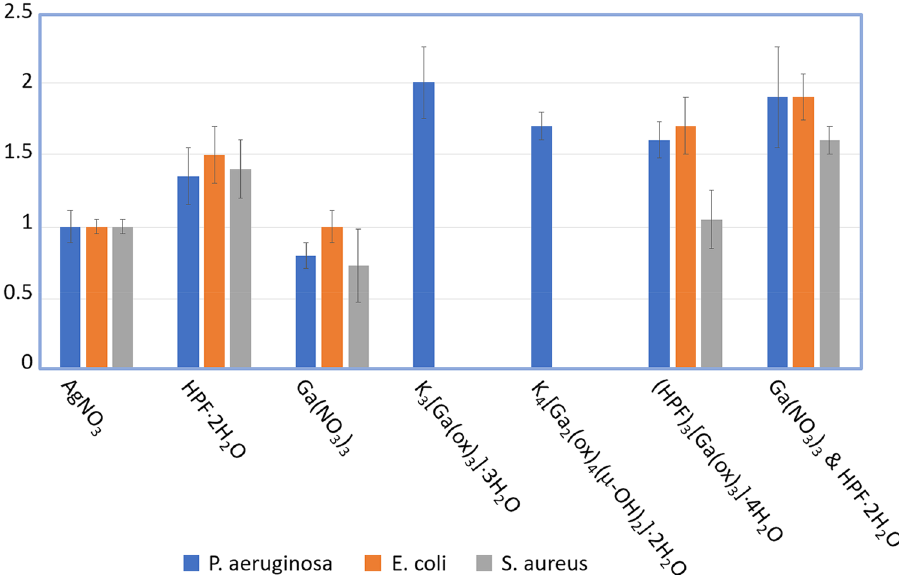
Figure 6. Antimicrobial efficacy of gallium compounds in comparison with proflavine and silver nitrate. The bars represent antimicrobial zone of inhibition assay where data are normalized to zone of AgNO 3 . The last set of columns on the right denotes effectiveness of combining the gallium nitrate salt with proflavine in solution both at 24 mg/mL, thus at higher molar load, and is designated by the ‘&’ notation. Data shows error deviations between trials. (n = 2–6